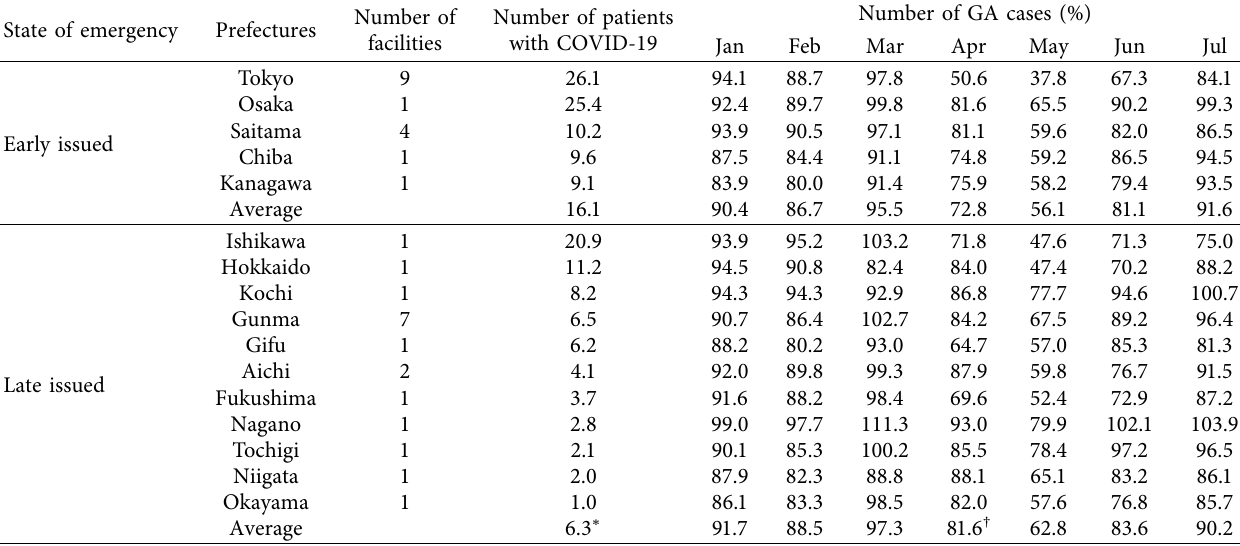
The “number of GA cases” reflects the number of GA cases in each prefecture normalized versus the number in July 2019. The data after January 2020, when the first case of COVID-19 was reported in Japan, are shown. Values with significant differences between the two groups are shown in bold. The symbols indicate significant differences between groups. ∗ ,† Early vs. late group ( P < 0 . 05).